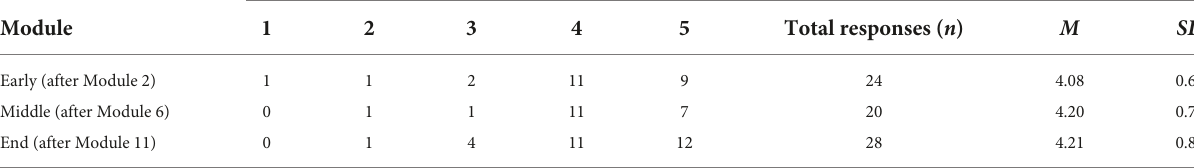
TABLE 6 Teacher evaluation of their level of understanding of module